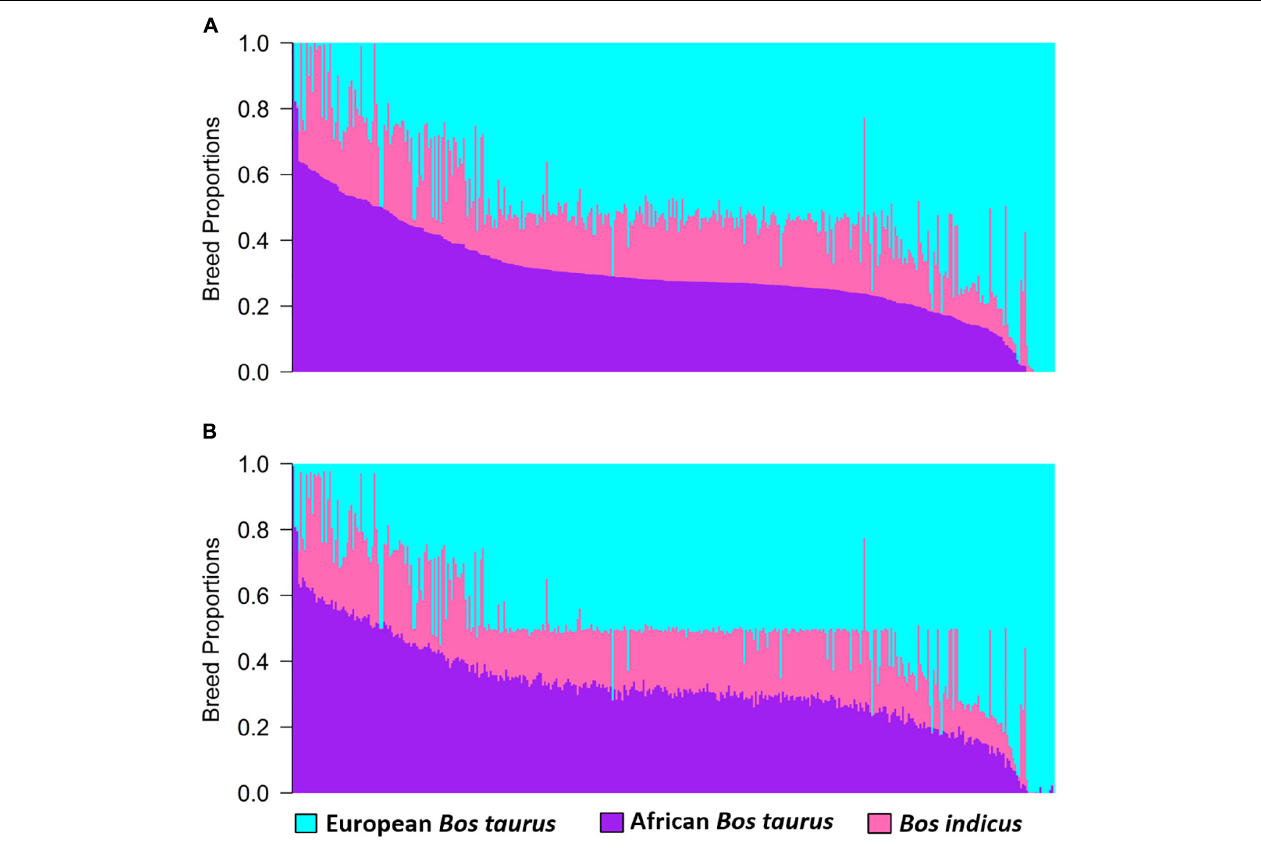
FIGURE 2 | Estimates of breed proportion of West African crossbreds using three-way admixture from (A) ADMIXTURE and (B) LAMP-LD.